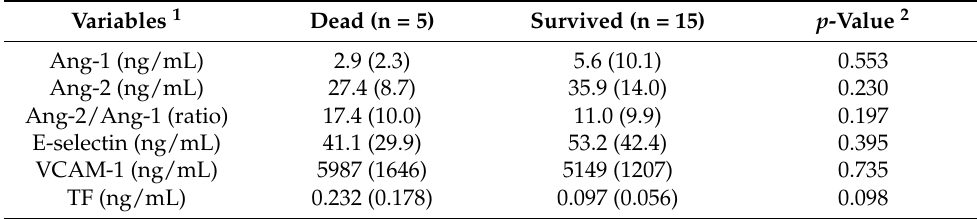
Table 3. Soluble endothelial markers at T1 and neonatal mortality in very preterm infants.